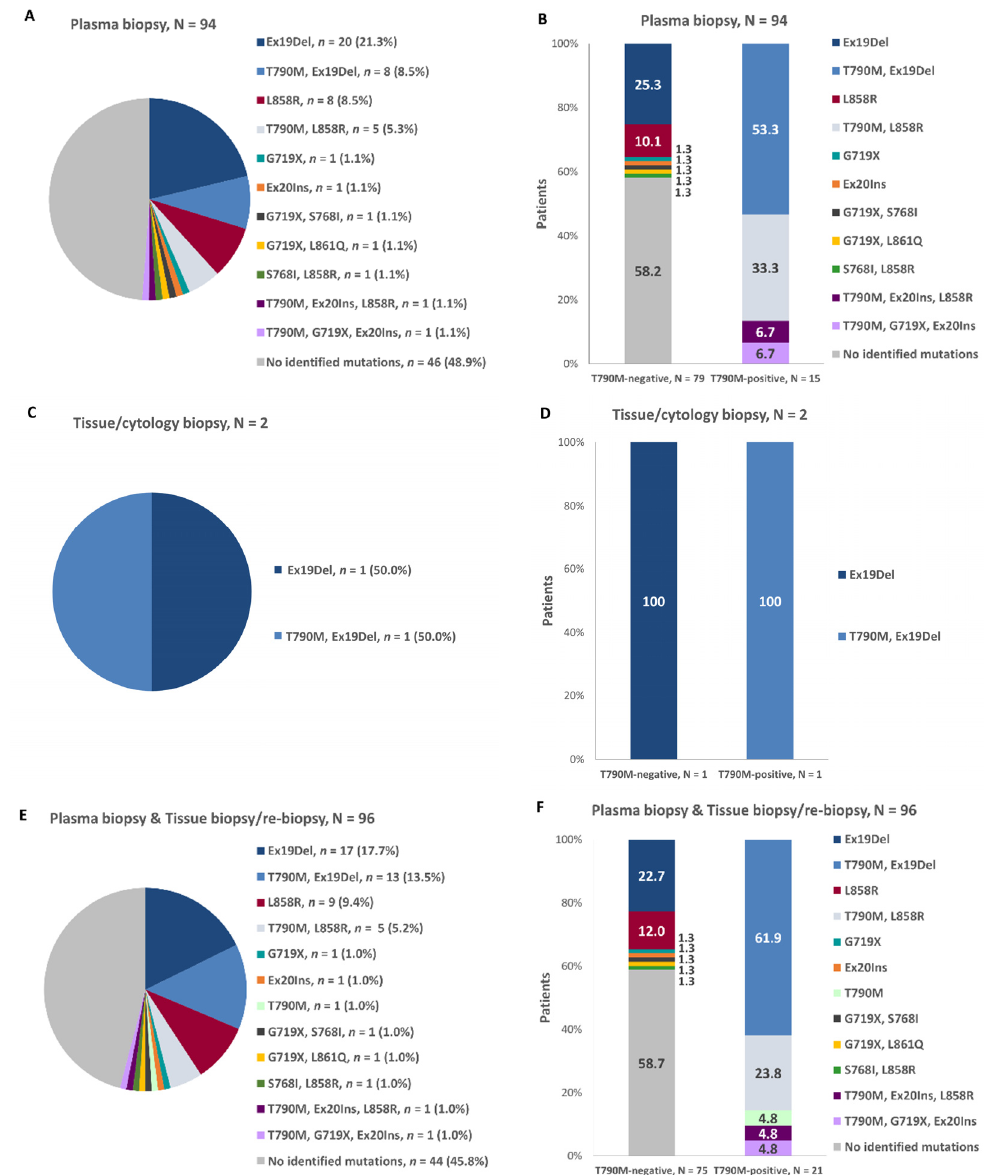
Figure 5. Mutations identified by cobas ® EGFR Mutation Test v2 during the initial plasma biopsy ( A , B ), initial tissue/cytology biopsy ( C , D ) and the initial plasma biopsy and the initial tissue biopsy or the re-biopsy ( E , F ), in the overall population ( A , C , E ) and the T790M-positive and–negative subpopulations ( B , D , F ). Ex19Del: exon 19 deletion; Ex20Ins: exon 20 insertion. Table 4. EGFR mutation profile of T790M positive patients at the time of progression on or after